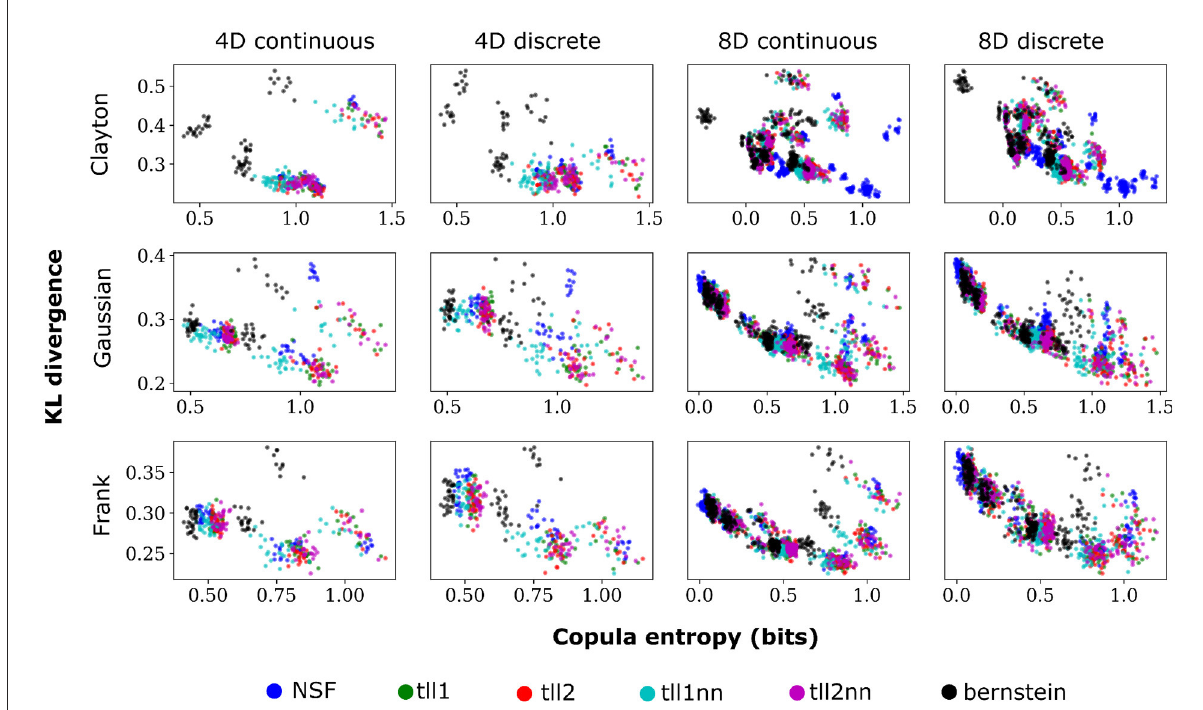
FIGURE5 Scatter plots of performance against copula entropy for NSFs vs. other non-parametric estimators on artificial data. All other conventions are the same as Figures 2, 3. Simulations shown in this figure had strong